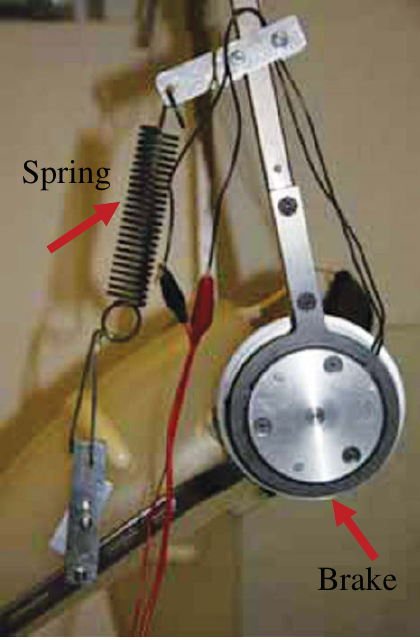
Fig. 3. Spring for knee flexion in